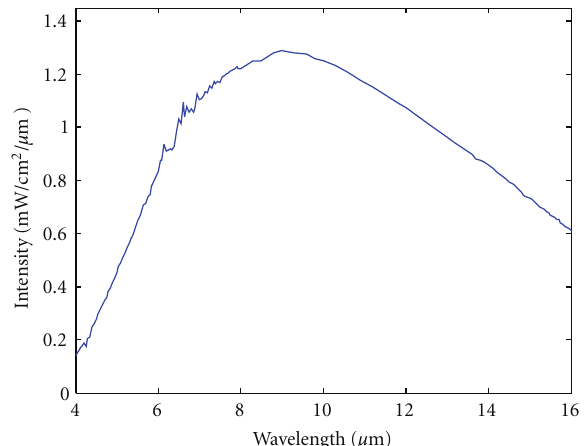
Figure 2: The FIR spectrum of the carbon fiber belt at 50 ◦ C. The total intensity of the wavelengths between 4 µ m and 16 µ m is 11.34 mW/cm 2 .